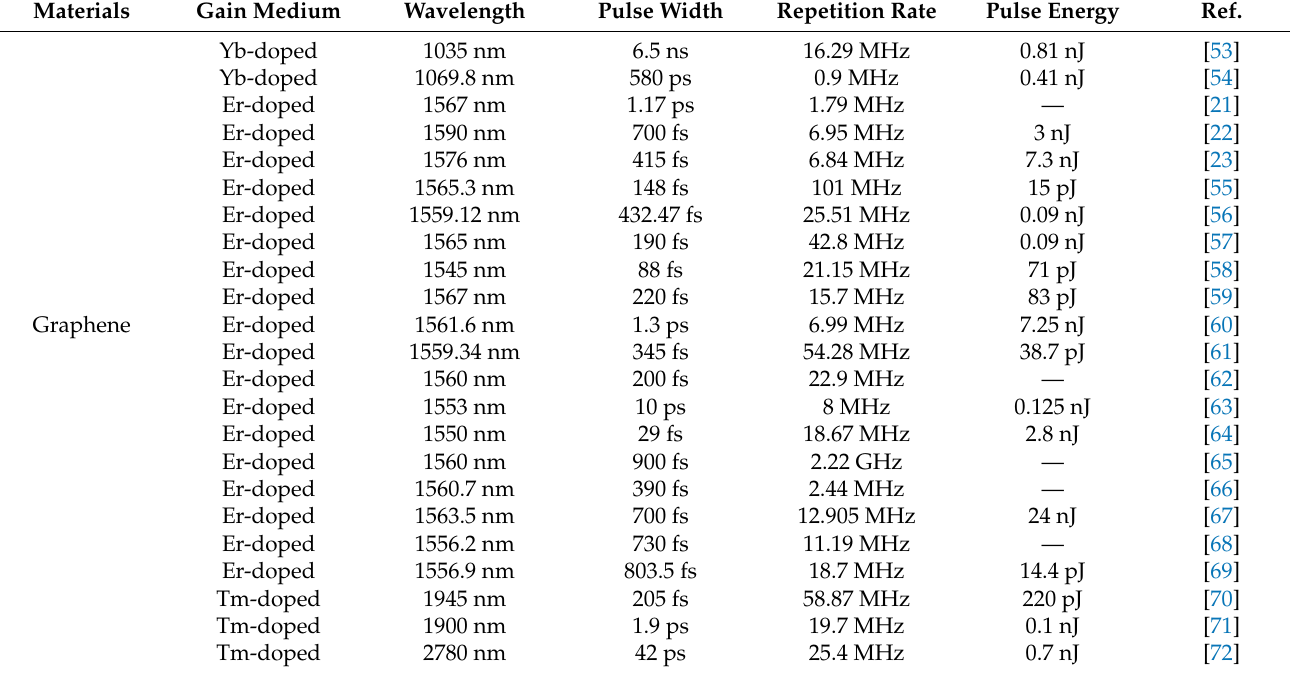
Figure 7. Measured optical spectra ( a ) and pulse durations ( b ) of the TDFL for different numbers of graphene layers in the SA. Reproduced from ref. [61]. Optical Society of America, 2015. Table 2. Summary of passively mode-locked fiber lasers with graphene materials.